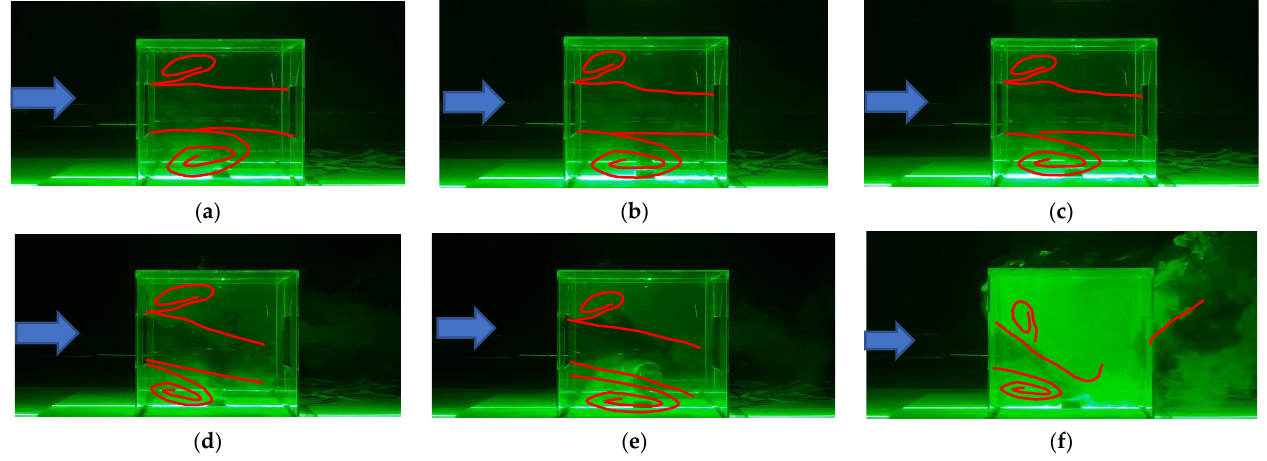
Figure 6. Flow and dispersion measured using the laser sheet-CCD concentration testing system under different Ri . ( a ) Ri = 0; ( b ) Ri = 0.04; ( c ) Ri = 0.27; ( d ) Ri = 1.86; ( e ) Ri = 5.31; ( f ) Ri = 11.11 .